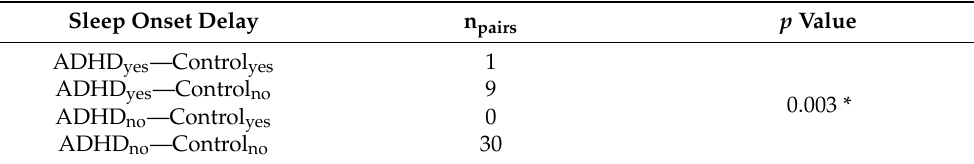
Table 7. Comparison of sleep onset delay between ADHD and control